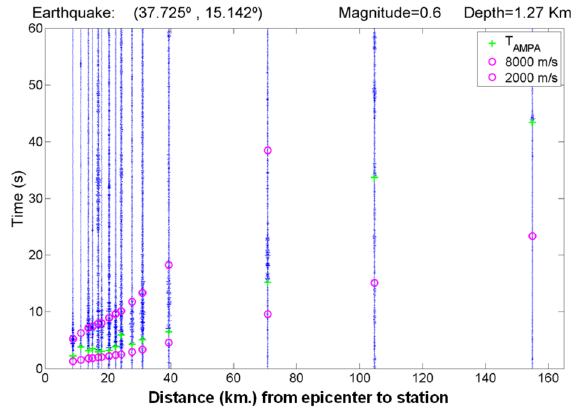
Figure 13. Automatic P-phase picking using AMPA for the earth- quake of magnitude 0.6 and depth 1.27 km shown in Figure 5b. Sta- tions are ordered starting from the closest to the most distant to the epicenter of the earthquake.